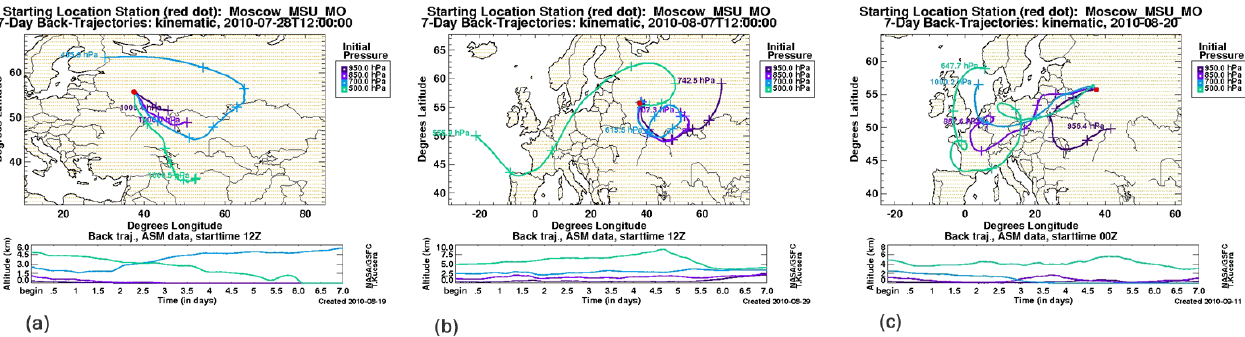
Fig. 3. NASA/GSFC 7-days backward trajectories for the day with typical synoptic situation in July (28 July) – (a) , for the day with the strongest fire cloud over Moscow and Zvenigorod (7 August) – (b) , and for the day after the fires (20 August) – (c) .